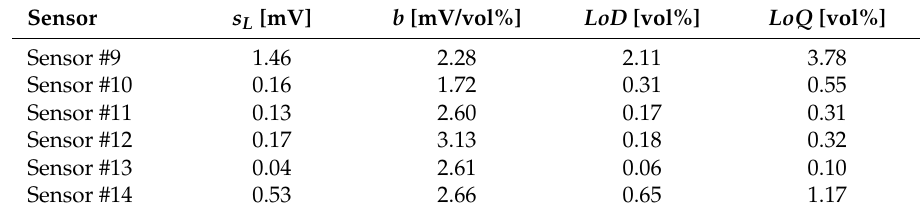
Table A2. Determination of the Limit of Detection ( LoD ) and Limit of Quantification ( LoQ ) values for all hydrogel-based ethanol sensors in Section